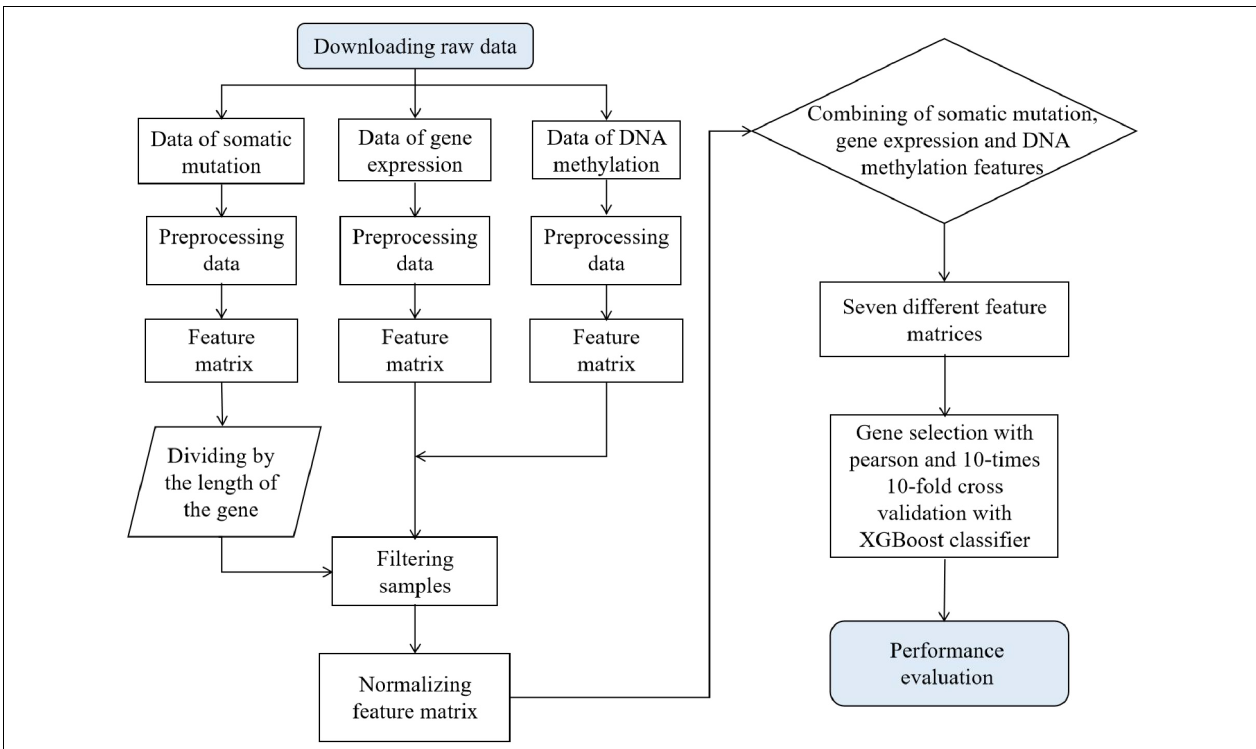
FIGURE 1 | Flow diagram of prediction on cancer tissue origin and performance evaluation. Seven different feature matrices, respectively, are gene expression feature matrix, somatic mutation feature matrix, DNA methylation feature matrix, both gene expression and somatic mutation feature matrix, both gene expression and DNA methylation feature matrix, both DNA methylation and somatic mutation feature matrix, and the feature matrix that combines these three biomarkers.